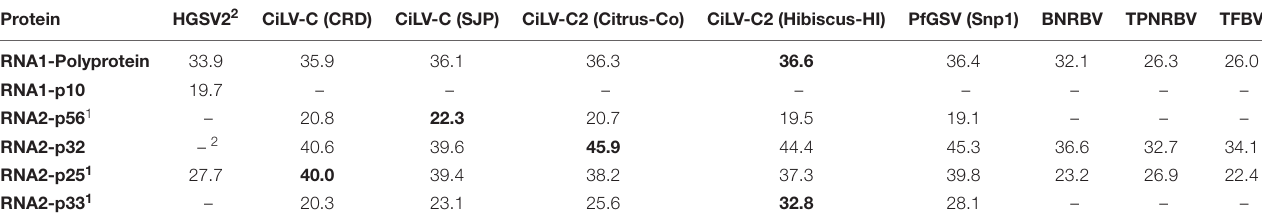
TABLE 1 | Percent amino acid identities between orthologous proteins of hibiscus yellow blotch virus (HYBV) and Kitaviridae members: higreviruses include: hibiscus green spot virus 2 (HGSV-2); cileviruses include: citrus leprosis virus C (CiLV-C) and CiLV-C2 (with isolates indicated), and the proposed cilevirus, passion fruit green spot virus (PfGSV); blunerviruses include, blueberry necrotic ring blotch virus (BNRBV) and tea plant necrotic ring blotch virus (TPNRBV), and the putative blunervirus tomato fruit blotch virus (TFBV). Protein